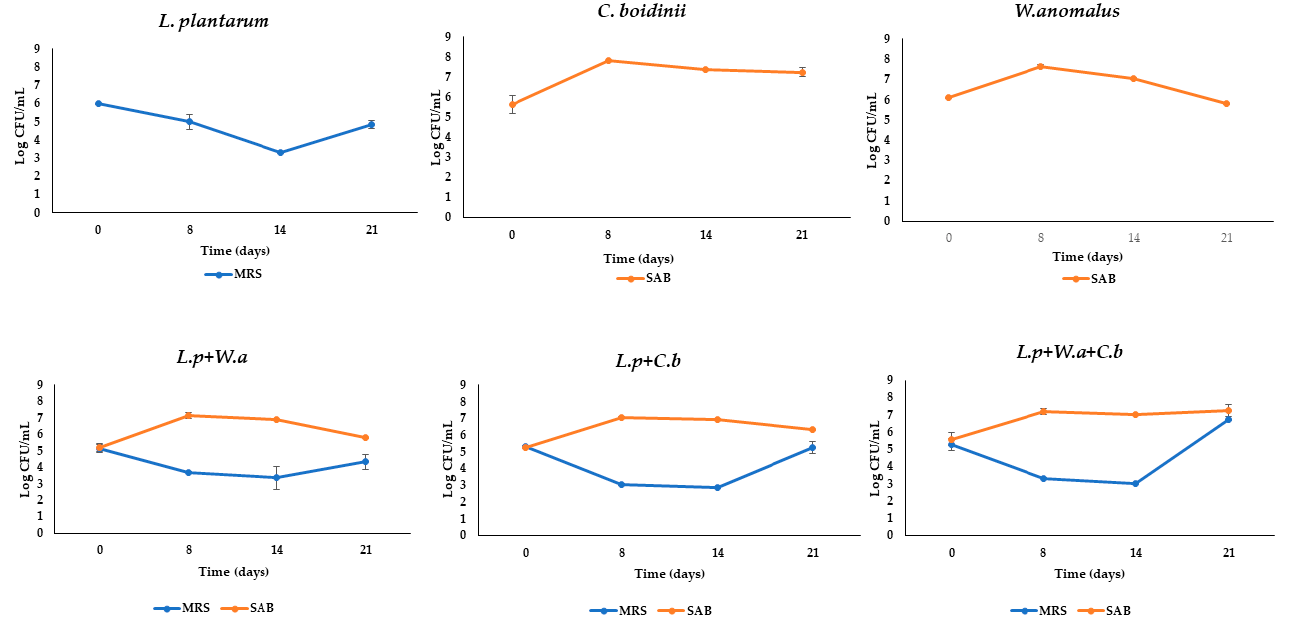
Figure 1. Microbial counts detected in MRS and SAB during fermentation in microfiltered OMWW differently inoculated. Data are expressed as means of Log CFU/mL ± standard deviations.